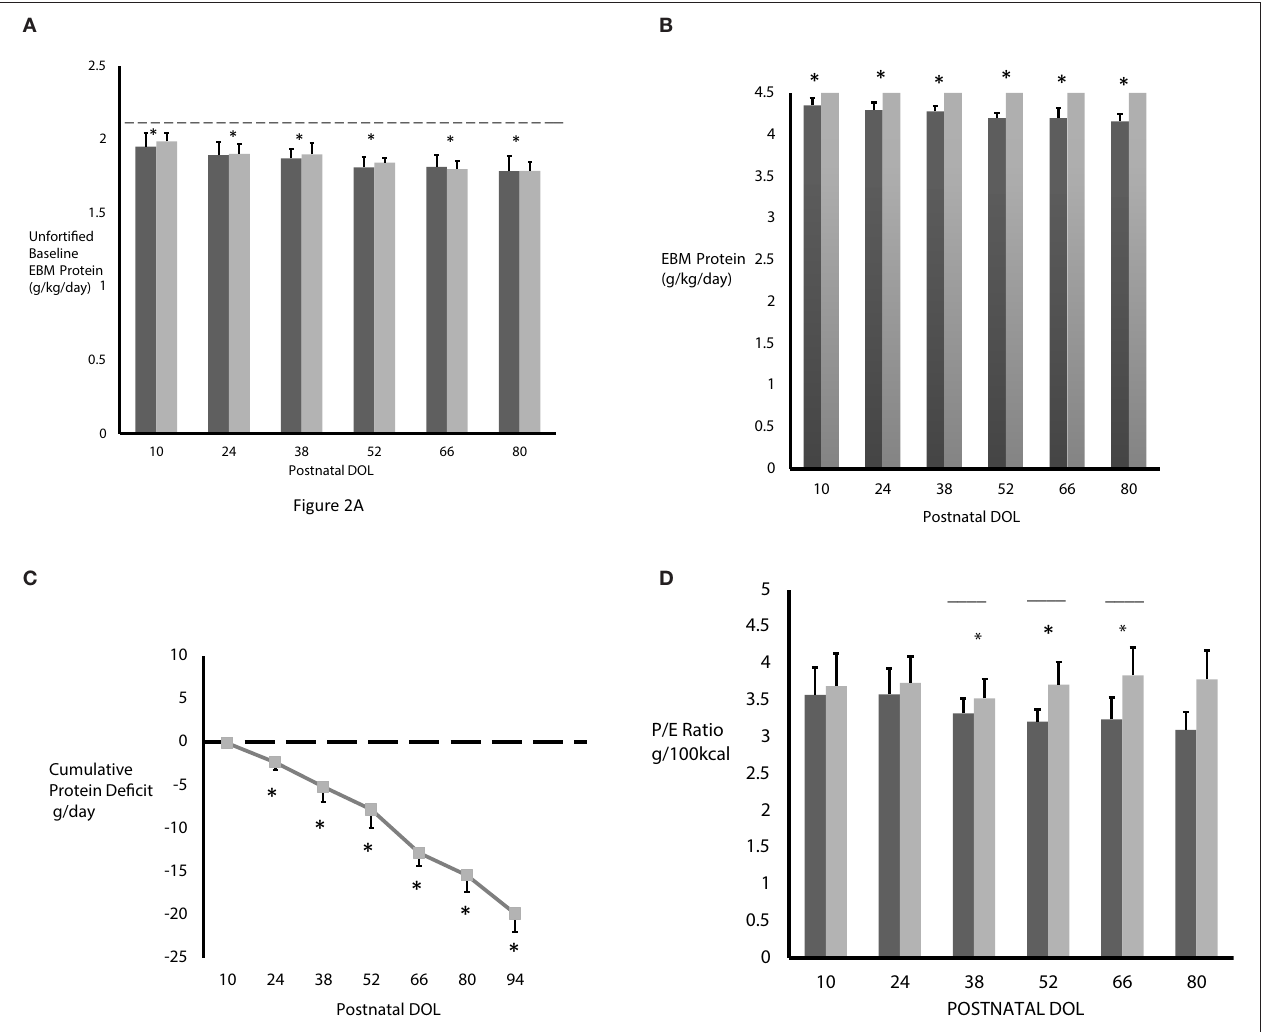
FIGURE 2 | (A) The measured baseline EBM protein intake was significantly less in both CG ( n = 3–20, dark gray bars) and IG ( n = 5–30, light gray bars) compared to predicted protein content based on published mean EBM values of 2.1 g/kg/day from 150 mL/kg/day intake (horizontal dashed line). [* p < 0.0001 by ANOVA, predicted (dashed line) vs. measured baseline protein intake]. (B) The fortified EBM protein intake never reached the projected 4.5 g/kg/day in the control group on standard fortification ( n = 3–20, dark gray bars) and progressively decreased over time. Protein intake in the interventional group on individualized fortification ( n = 5–30, light gray bars) reached the goal of 4.5 g/kg/day. * p < 0.001 by ANOVA. (C) Without individualized fortification, subjects in CG accumulated a significant protein deficit over time. Protein deficit in IG is zero (dashed horizontal line). * p < 0.0001 by ANOVA at DOL 52, 66, 80; N = 3–20. (D) The P/E ratio was lower in CG ( n